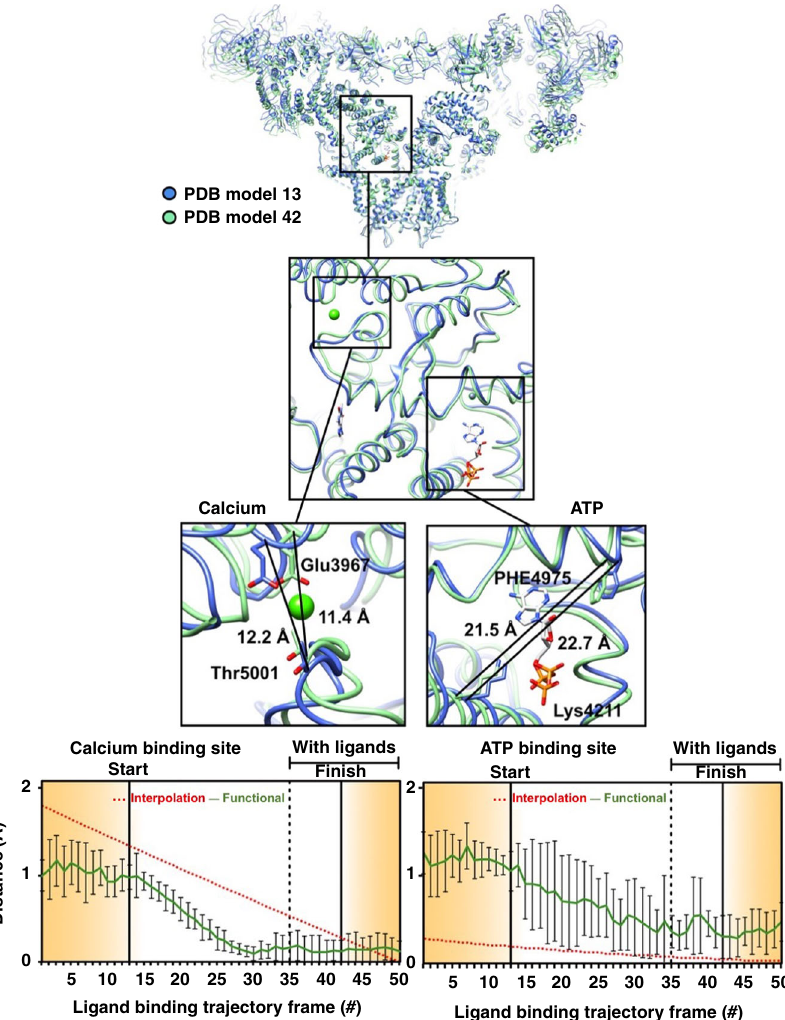
Fig. 2 Conformational changes at calcium and ATP-binding sites along the functional path. Ryanodine receptor 1 (RyR1) conformational changes at calcium and ATP-binding sites along the functional trajectory of Fig. 1a, augmented with excursions from the minimum-energy points along CC1. These excursions are in the increasing CC1 direction on the no-ligand landscape, and in the decreasing CC1 direction on the with-ligand landscape. Top: The general region and the speci fi c sites examined in detail. Distance variations between two amino acid backbones on the opposite side of the ATP and calcium are shown. The amino acids used for measurement are represented as sticks, the rest of the molecule in blue ribbon for the model corresponding to “ START ” in Fig. 1a, and in green ribbon for model corresponding to “ FINISH ” . Bottom: Distance variations between carbon-alpha backbone atoms of two opposing residues at each of the calcium and ATP binding sites for 50 structures along the functional and interpolated trajectories. For the latter, 50 structures were extracted from a morph between a model of RyR1 without ligands (PDB: 5TB4) and a model of RyR1 with calcium, ATP, and caffeine (PDB: 5T9V). To analyze the functional route, six published models (PDB: 5TB4, 5T9R, 5TAP, 5T9V, 5TAL, 5TAQ) were each fi tted and re fi ned into the maps along the trajectory. Error bars represent the full scatter (not standard deviation) of the results obtained with different starting